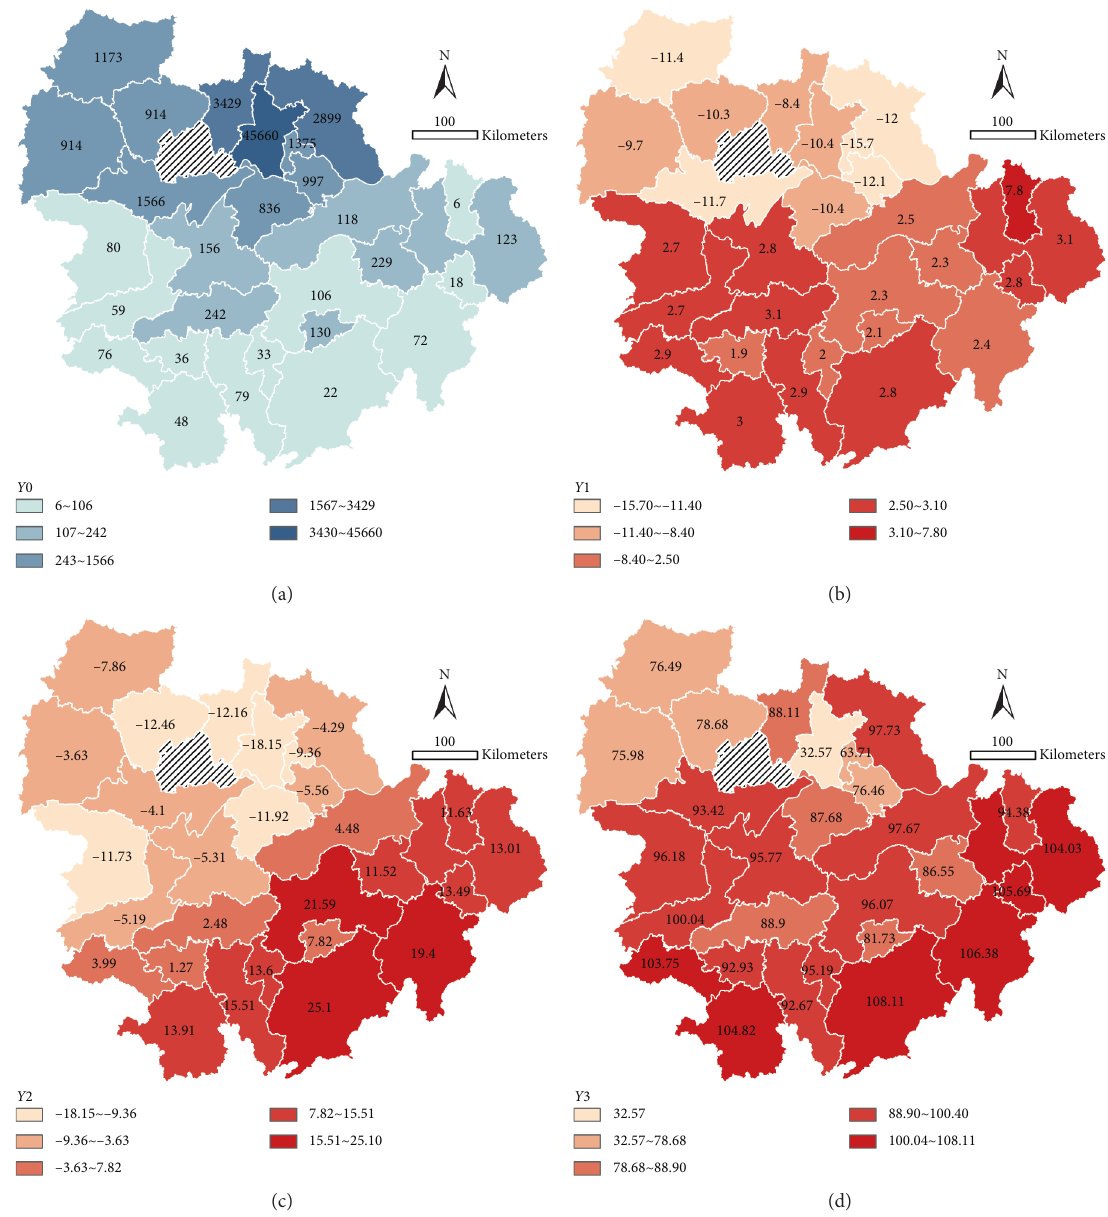
Figure 2: Pandemic disaster severity and urban resilience